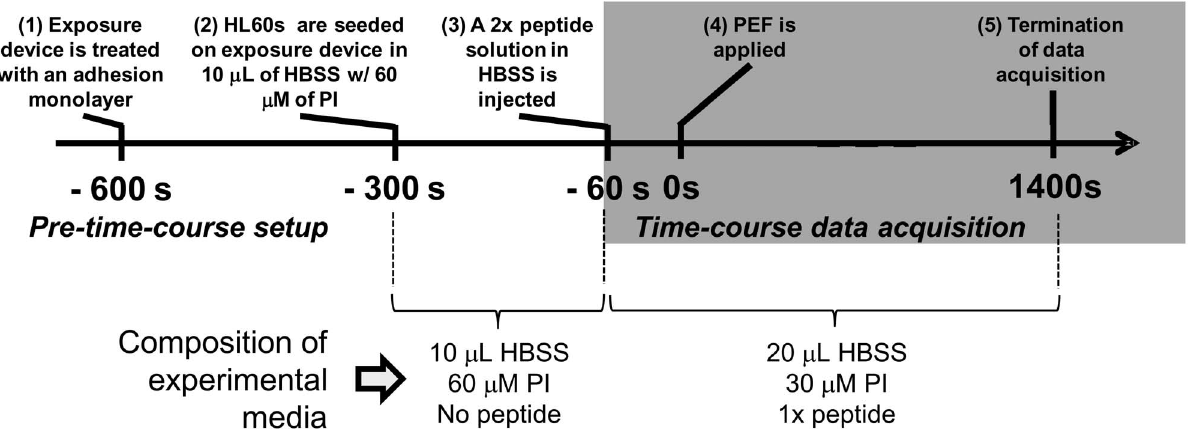
Figure 4. A timeline summarizing the experimental protocol. The microcuvette was treated with an adhesion peptide so that cells would settle into the microchannel and remain immobilized during experimentation. Cells and PI were added to the microcuvette 300 seconds prior to PEF exposure and allowed to settle into the microchannel. If peptides were used, at 60 seconds before PEF exposure, they were added at twice their desired concentration so that, when combined with the cell/PI mixture in a 1:1 ratio, they would dilute into the desired experimental concentration. Also at 60 seconds prior to PEF exposure, fluorescence imaging of the cells began (1 image every 10 seconds). At time 0, a PEF was administered and cells were imaged for 1400 seconds.